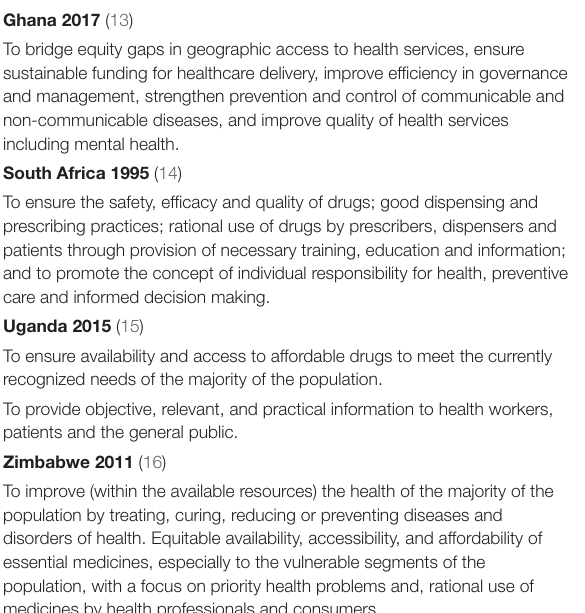
TABLE 1 | National Medicines Policies (NMPs) studied, together with their stated objectives.